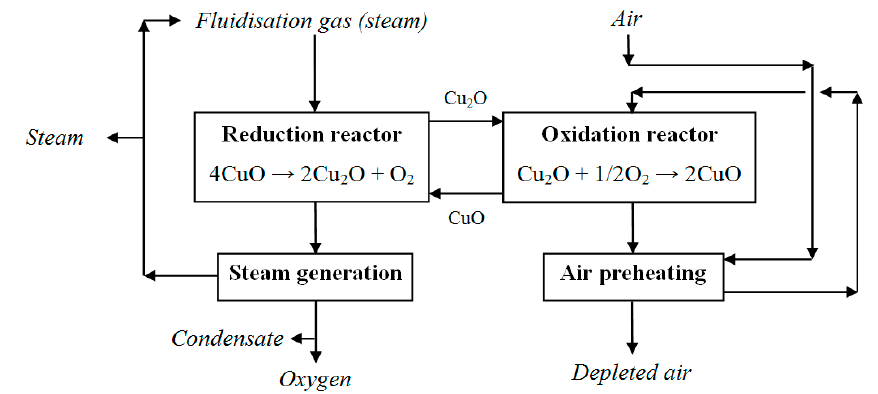
Figure 1. Design of copper-based chemical looping cycle used for oxygen production (CLAS).